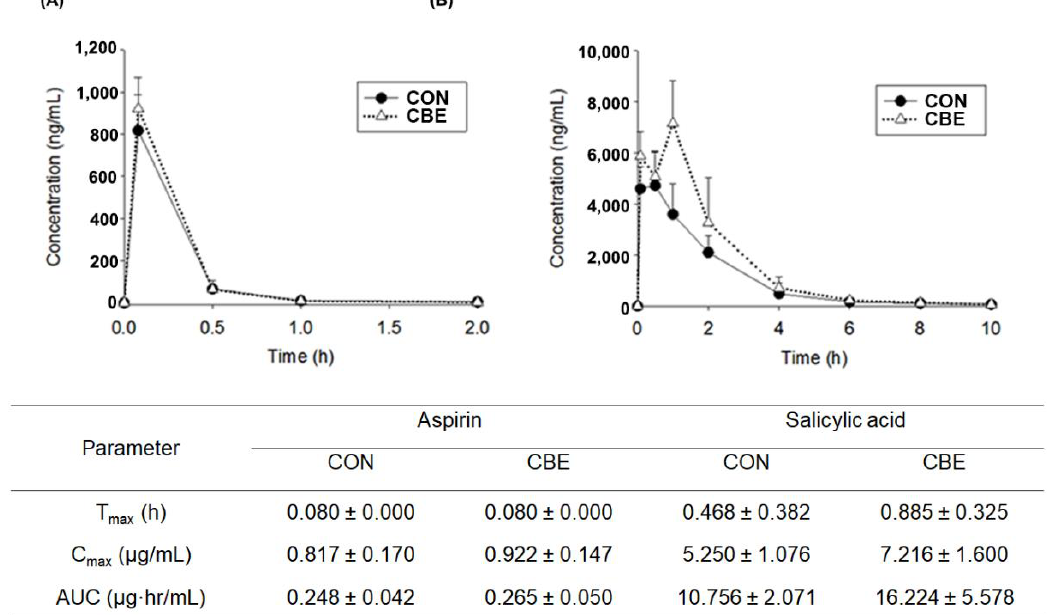
Figure 4. The plasma concentration of aspirin and salicylic acid. ( A ) The plasma concentration of aspirin in control (CON, treated with vehicle) and coffee bean extract (CBE)-treated mice. ( B ) The plasma concentration of salicylic acid in control (CON, treated with vehicle) and coffee bean extract (CBE)-treated mice. Aspirin (5 mg/kg) was orally or intravenously administered to mice for 3 days. Data shown are the mean ± S.D. ( n =